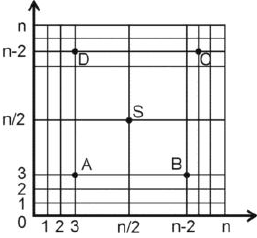
Fig. 4. Positions of points A, B, C, D, S on the middle plate